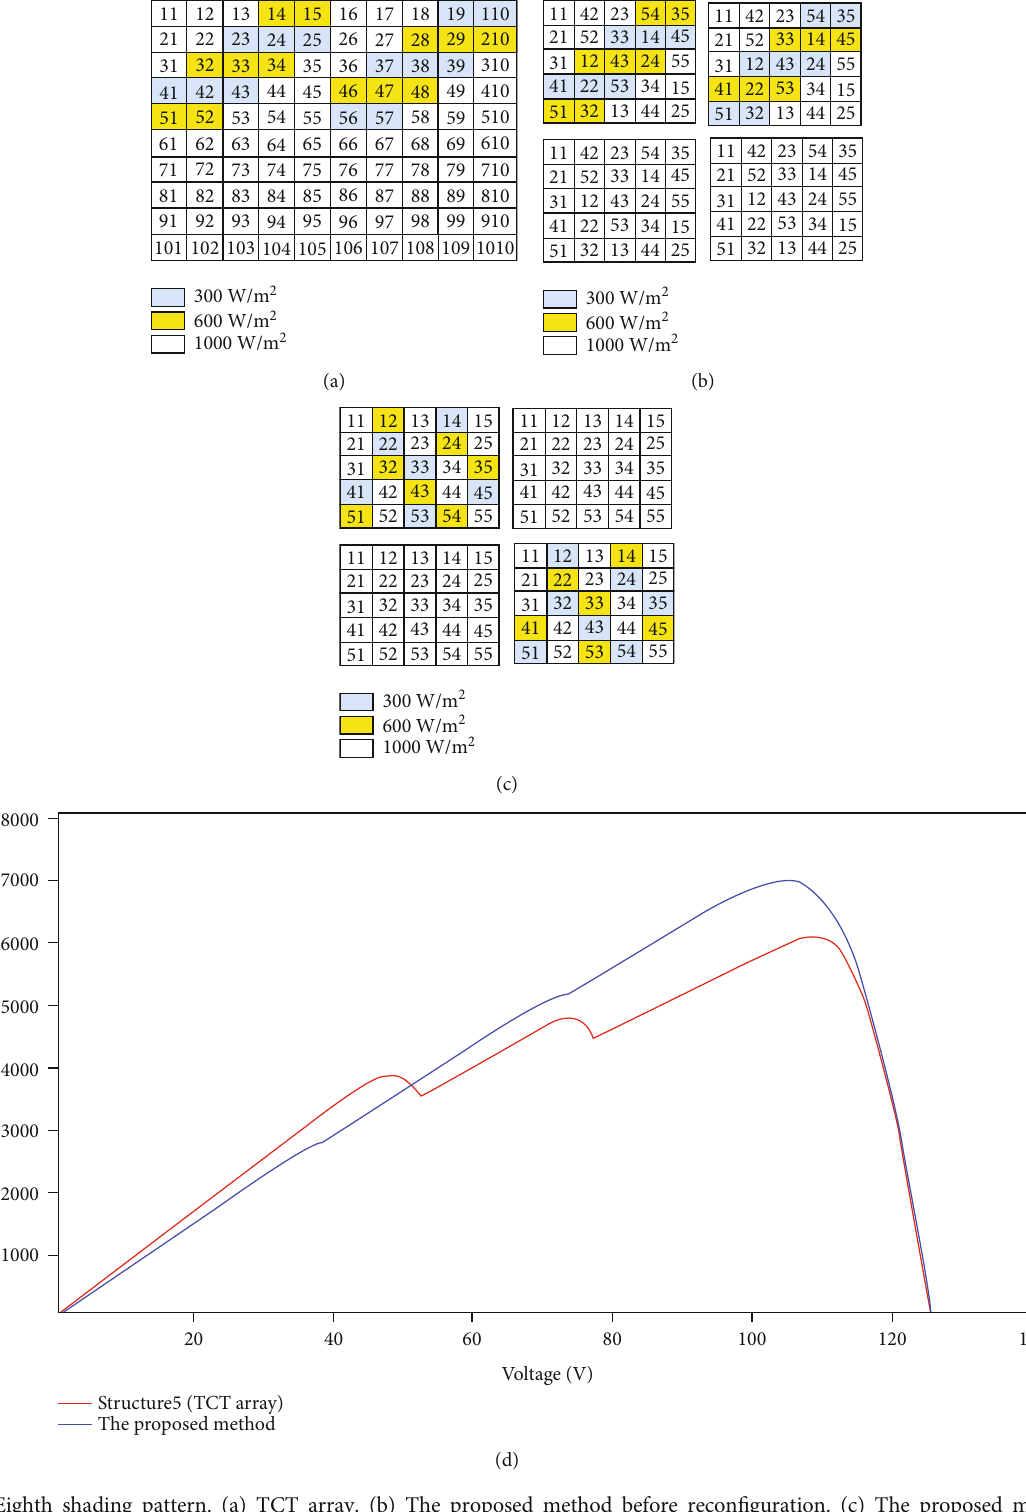
Figure 17: Eighth shading pattern. (a) TCT array. (b) The proposed method before recon fi guration. (c) The proposed method after recon fi guration. (d) The PV array characteristics for the TCT array and the proposed